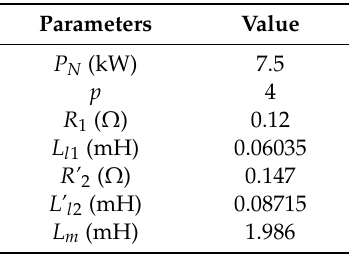
Table 1. Parameters of variable frequency asynchronous motor.